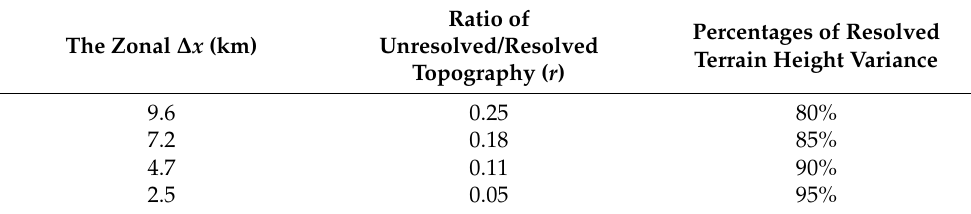
Table 3. The same as in Table 2, but for 90-m topographic resolution (R2). n ∆ x = 123.6 km and δ x = 0.079 km.